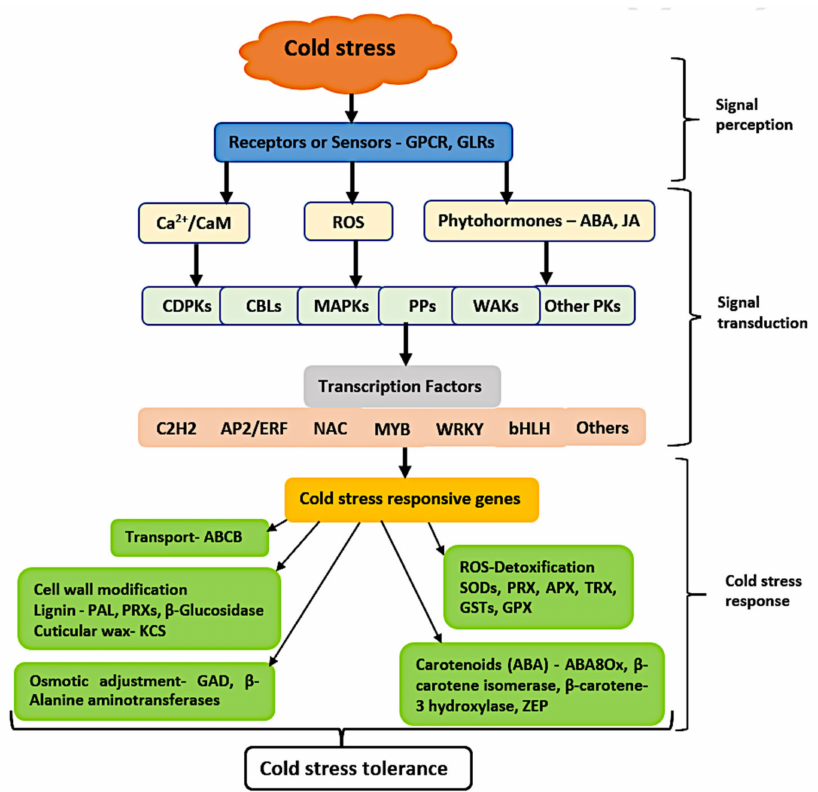
Figure 11. The schematic molecular model describing the signaling pathways involved in the acquisition of cold tolerance in maize seedlings. The model was constructed based on the main cold response components identified in this report, as well as plant abiotic stress pathway schemes previously described. The downward pointing arrows represent the sequence of events in cold tolerance in maize, from stress signal perception to acclimation mechanisms. Abbreviation key: GPCR, G-protein-coupled receptor; GLR, glutamate receptor; ROS, reactive oxygen species; ABA, abscisic acid; JA, jasmonic acid; CDPKs, calcium-dependent protein kinases; MAPK, mitogen- activated protein kinase; PPs, protein phosphatase; WAKs, wall-associated kinases; PKs, protein kinases; PRX, peroxidases; PAL, phenylalanine ammonia lyase; KCS, ketoacyl-CoA synthase; GAD, glutamate decarboxylase; SOD, superoxide dismutase; APX, ascorbate peroxidase; TRX, thioredoxin; GST, glutathione transferase; GPX, glutathione peroxidase; ZEP, zeaxanthin